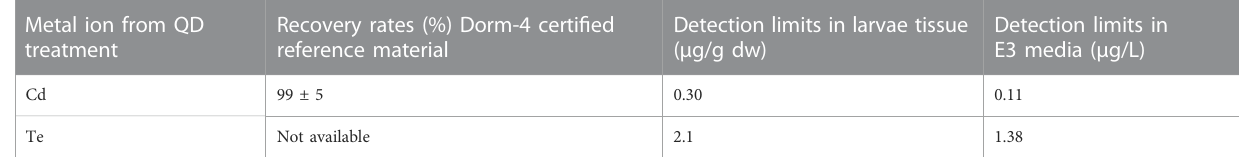
TABLE 1 Recovery rates (%) and detection limits of cadmium and tellurium from larval tissue and E3 media samples.